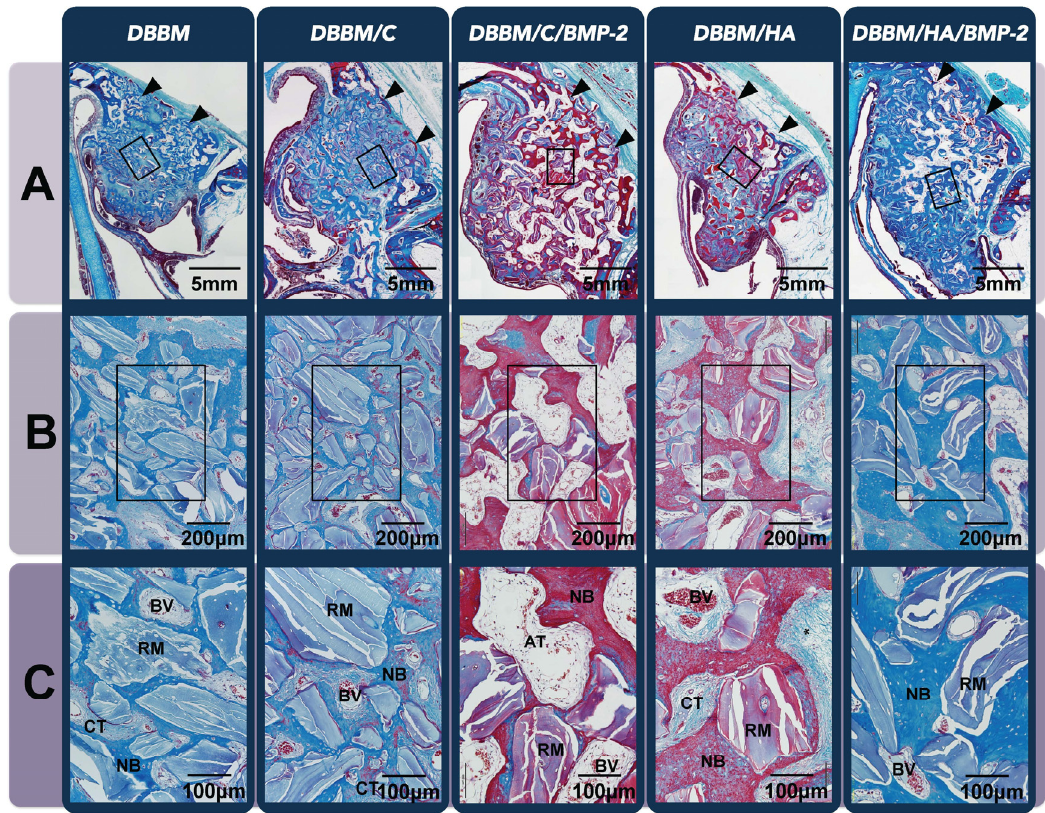
Figure 4. Histologic analysis in the rabbit sinus ‐ augmentation model at the eight ‐ week healing point. ( A ) Low ‐ magnification image of the entire sinus ‐ augmentation site in each groups after eight weeks of healing (Masson’s trichrome staining, original magnification ×40, scale bar = 5 mm). Newly formed bone (NB) was evenly distributed at all of the grafted area regardless of the experimental group, and appeared as a more mature type with increased lamellar bone compared to the sites in the two ‐ week groups; ( B ) Representative high ‐ magnification view (Masson’s trichrome staining, original magnification ×100, scale bar = 200 μ m); ( C ) A twofold ‐ enlarged image in the center of ( B ) (Masson’s trichrome staining, magnification ×200, scale bar = 100 μ m). There was a very large amount of adipose tissue (AT) formation within the grafted area in both samples that received rhBMP ‐ 2, and it was significantly higher in the DBBM/C/BMP ‐ 2 group than in the DBBM/HA/BMP ‐ 2 group. Samples of the other three groups showed dense connective tissues (CT) in the area between the residual material (RM) and NB. Reduction of AT formation when using an HA ‐ coated collagen as a carrier for BMP ‐ 2 enhances the bone quality. Arrowheads, surgically created entrance of window opening; DBBM, deproteinized bovine bone mineral; C, absorbable collagen sponge; BMP ‐ 2, bone